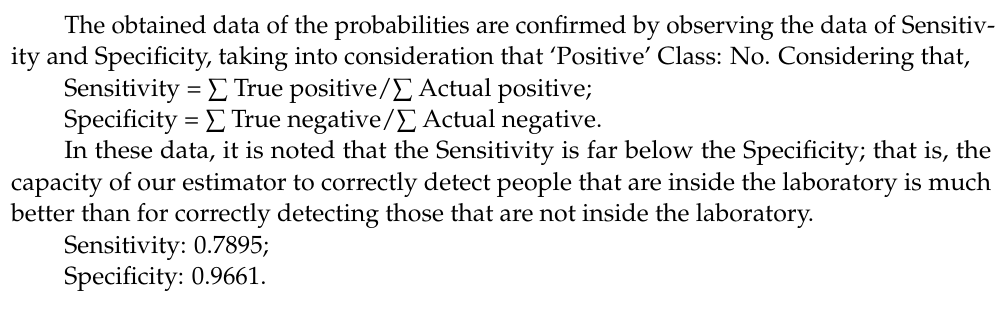
Figure 2. Histogram of probabilities distribution. Logistic regression